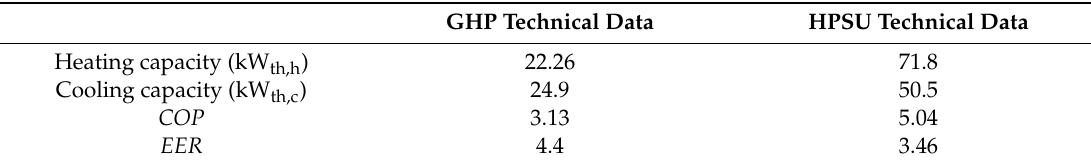
Table 2. Geothermal energy system technical data.